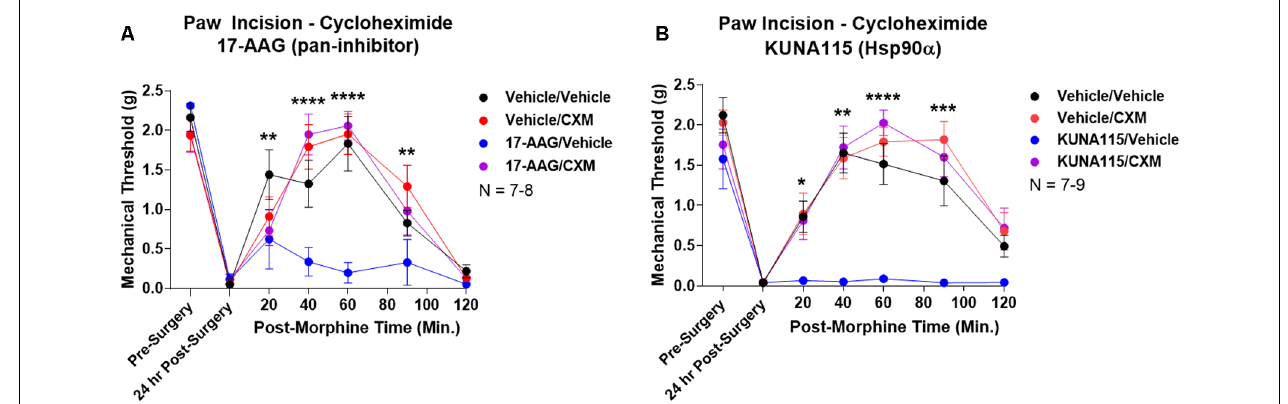
FIGURE 5 | Rapid protein translation is required for Hsp90 inhibition to impact opioid anti-nociception. Male and female CD-1 mice treated with 0.5 nmol 17-AAG (A) or 0.1 nmol KUNA115 (B) or vehicle icv , 24 h, followed by 85 nmol cycloheximide or vehicle icv , 30 min, followed by 10 mg/kg morphine sc . No difference between approximately equal male and female groups ( p > 0.05) so they were combined for this analysis. Data reported as the mean ± SEM with the sample size of mice/group noted in the graph. Performed in three technical replicates by different experimenters. ∗ , ∗∗ , ∗∗∗ , ∗∗∗∗ p < 0.05, 0.01, 0.001, 0.0001 for the 17-AAG/Vehicle group vs. any of the other three groups at the same time point by two-way ANOVA with Fisher’s Least Significant Difference post hoc test. There were no differences between the Vehicle/Vehicle, Vehicle/CXM, or 17-AAG/CXM groups.